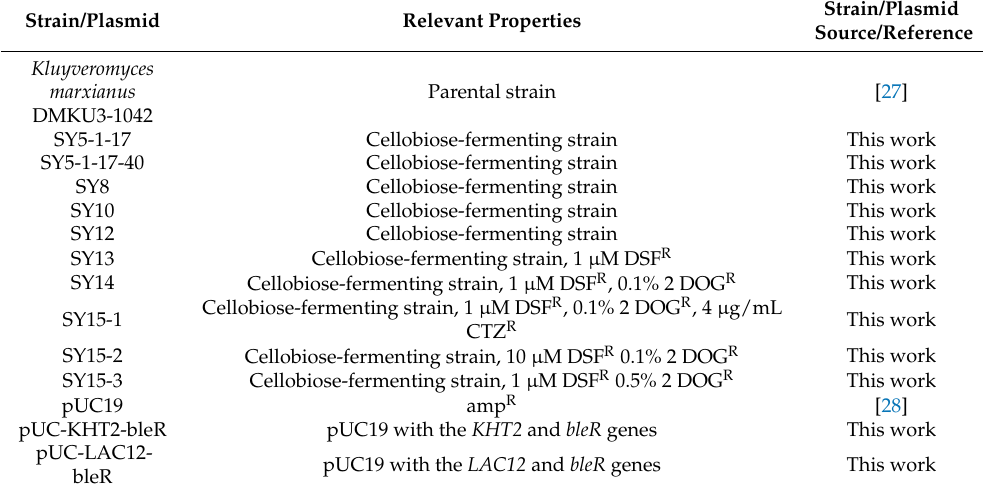
Table 1. Strains and plasmids used in